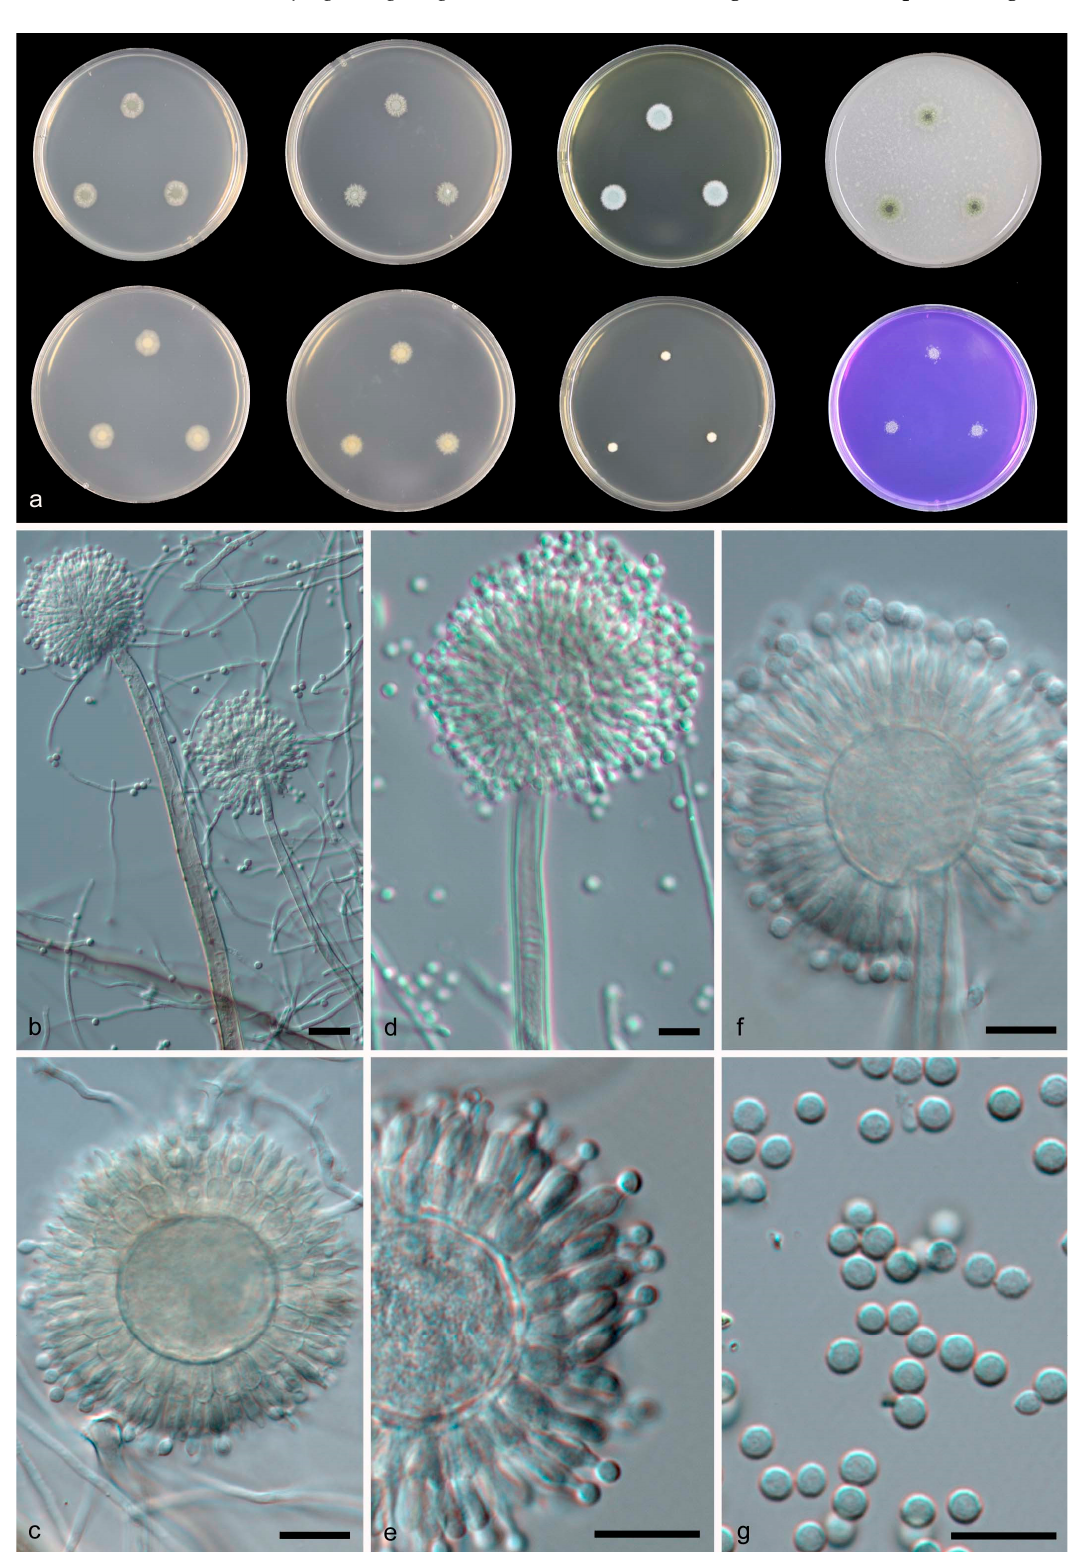
Figure 3. Aspergillus guangxiensis CGMCC 3.19709 T. ( a ) Colonies: top row left to right, obverse CYA, obverse MEA, YES and OA; bottom row left to right, reverse CYA, reverse MEA, DG18 and CREA. ( b – f ) Conidiophores. ( g ) Conidia. Scale bars: b = 20 μ m; c–g = 10 μ m.